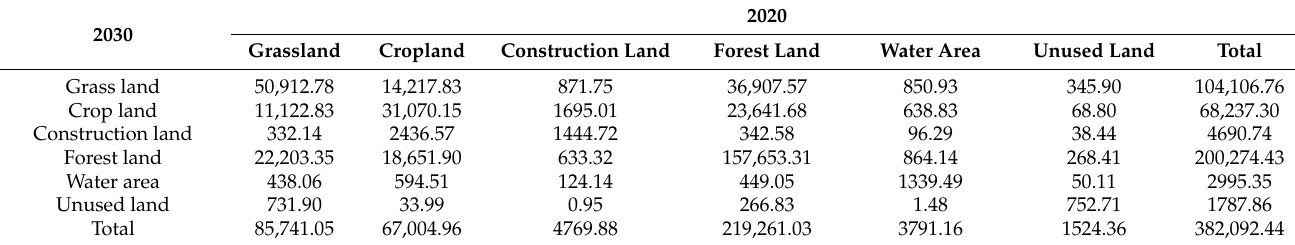
Table 5. Land use transfer matrix of Yunnan Province from 2020 to 2030 (km 2